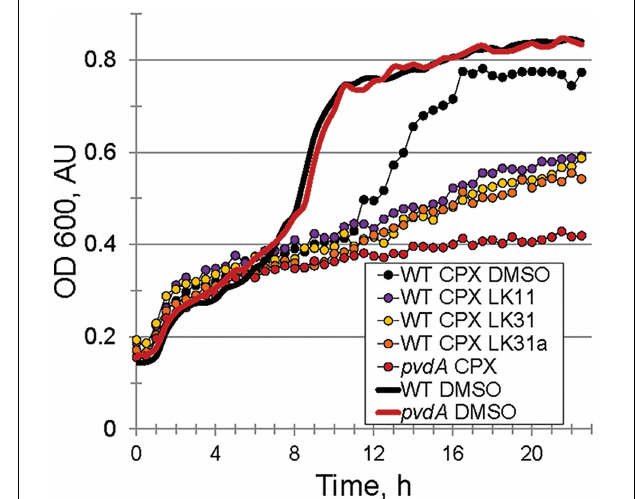
FIGURE 6 | Pyoverdine inhibitors disrupt bacterial growth under iron-limiting condition. Growth curves of WT P. aeruginosa PA14 and PA14 pvdA . Iron limitation was induced by the presence of 6.5 µ M ciclopirox olamine (CPX), an iron (III) chelator. DMSO or compounds were added at 100 µ M. Three biological replicates were